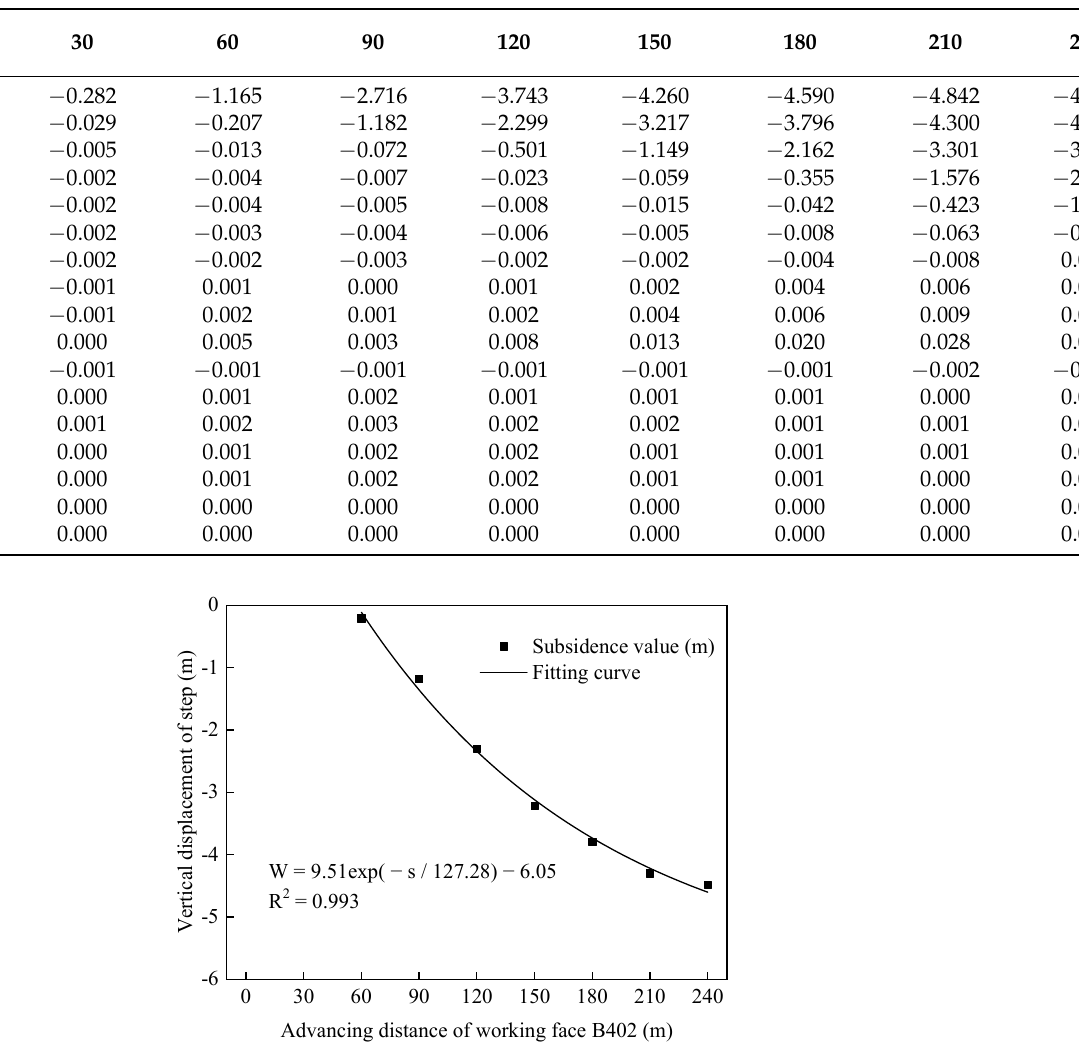
Table 3. Vertical displacement of steps during working face advancement.